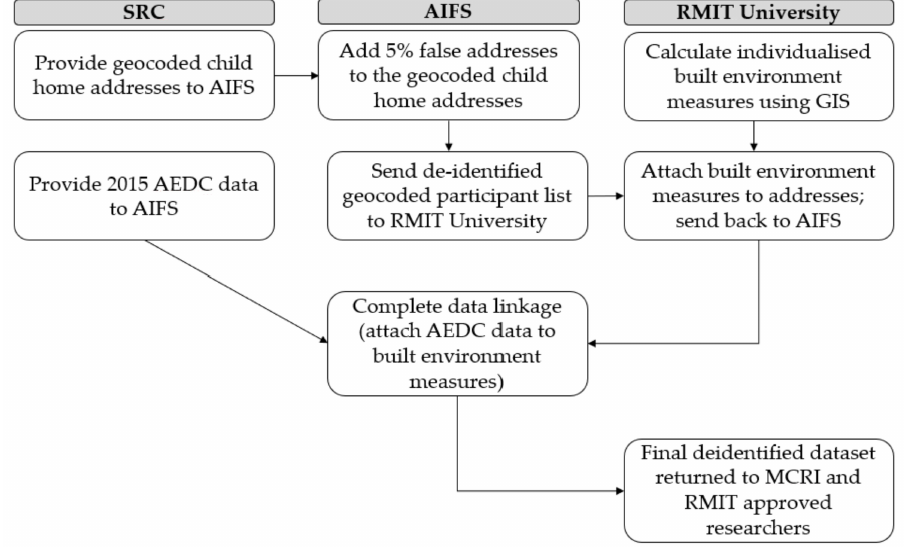
Figure 1. Steps in the AEDC-BE data linkage process. AEDC: Australian Early Development Census. AIFS: Australian Institute of Family Studies. MCRI: Murdoch Children’s Research Institute. SRC: Social Research